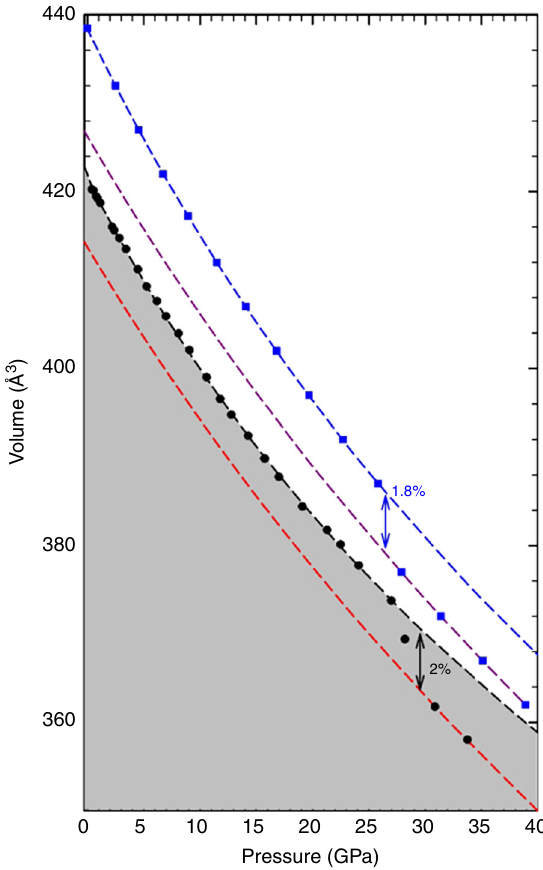
Fig. 2 Evolution of the volume under compression. Experimental data (black circles), theoretically simulated data (blue squares) and the fi ts to 3rd order Birch – Murnaghan equation (dashed line)